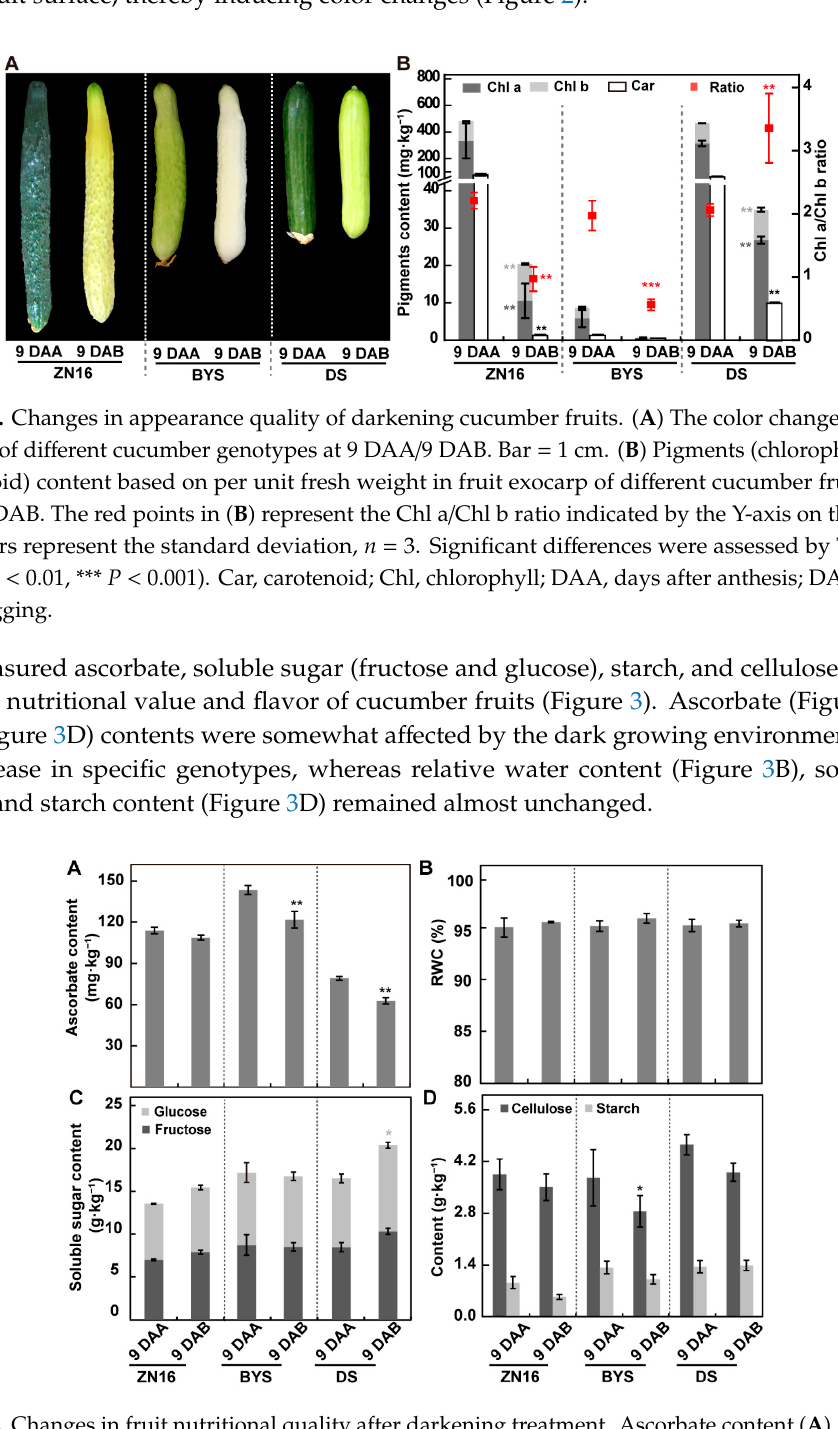
Figure 3. Changes in fruit nutritional quality after darkening treatment. Ascorbate content ( A ), relative water content (RWC) ( B ), soluble sugars (fructose and glucose) content ( C ), and starch and cellulose content ( D ) of fruits at 9 DAA/9 DAB. Bars represent means ± standard deviations ( n = 3); significant differences were assessed by Tukey’s test (** P < 0.01, * P < 0.05). The light grey asterisk in ( C ) indicates a significant difference in glucose content.